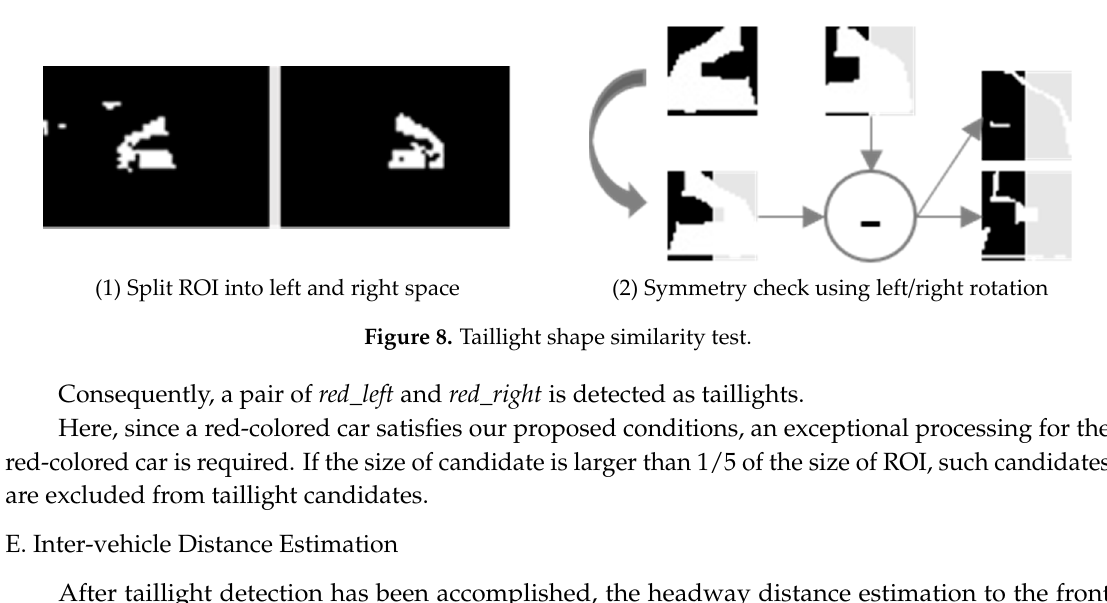
Figure 8. Taillight shape similarity test.